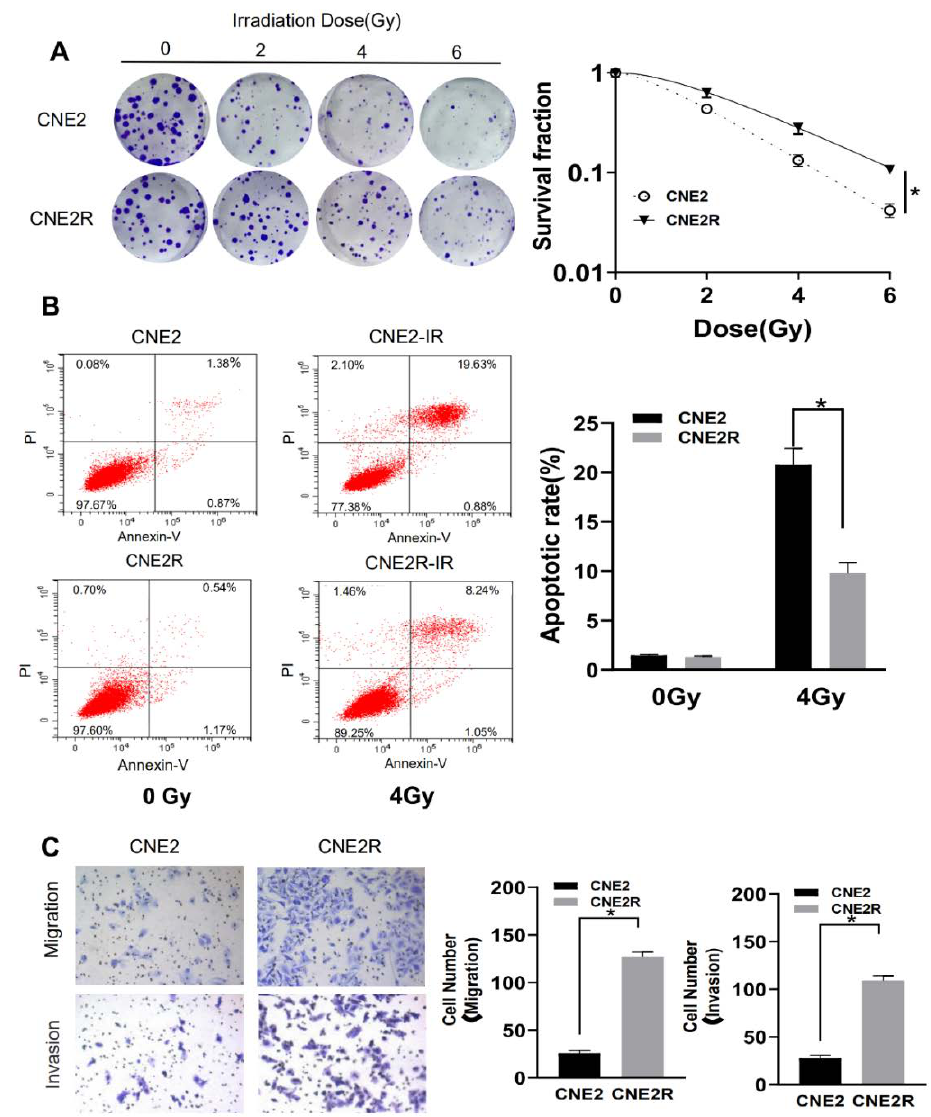
Figure 1. Validation of the radioresistant CNE2R cells by the measurements of colony formation, apoptosis, and cell migration. ( A ) Colony formation assay of the survival curve of CNE2R cells and its parent cell line CNE2 irradiated with different doses of γ -rays. ( B ) Flow cytometry assay of apoptosis of CNE2 and CNE2R cells irradiated with 4 Gy of γ -rays. ( C ) Migration assay and invasion assay of CNE2 and CNE2R cells. * p < 0.05 between indicated groups.